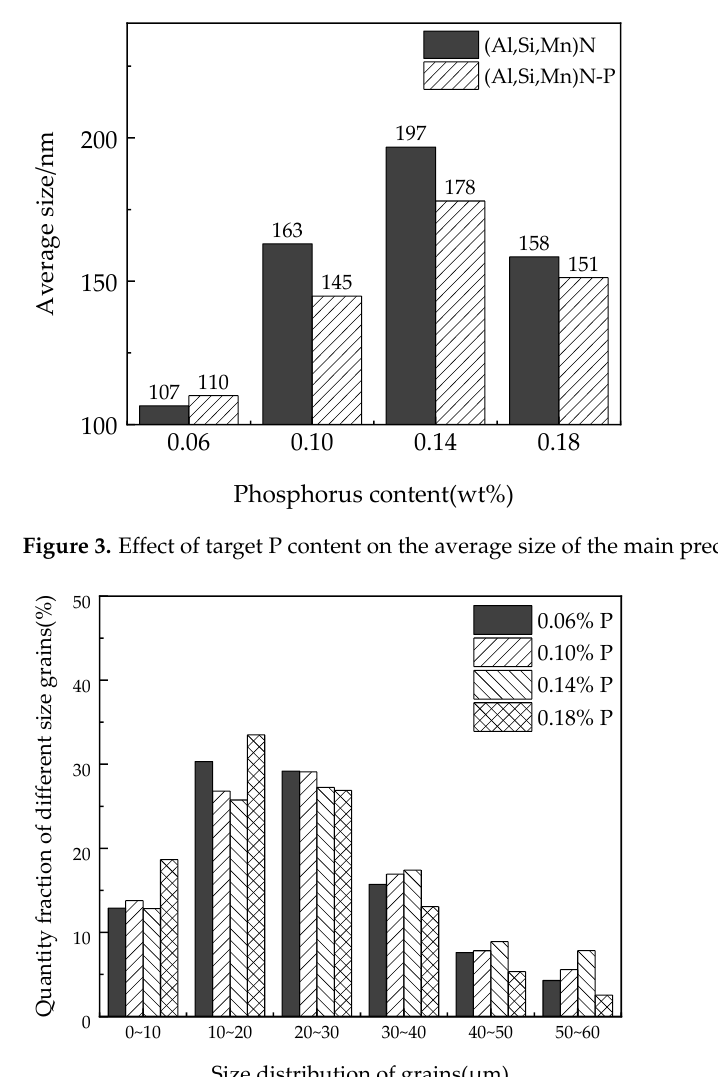
Figure 2. The number density and the average size of precipitates detected in the different P-bearing samples.